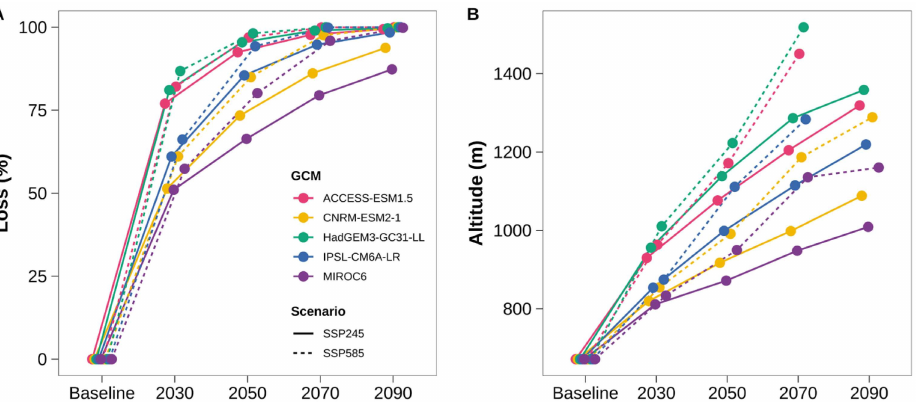
Figure 6. Future suitable habitat area loss (%) compared to the area under the baseline climate conditions (1970–2000) ( A ) and the mean altitude ( B ) of suitable habitat for Angelica gigas under the SSP245 and SSP585 scenarios of multiple GCMs using the committee averaging ensemble approach. Table 3. Predicted area (km 2 ) of suitable habitat for Angelica gigas under the SSP245 and SSP585 scenarios of multiple GCMs using the committee averaging ensemble approach. The numbers in parentheses are future suitable habitat area loss (%) compared to the area under the baseline climate conditions